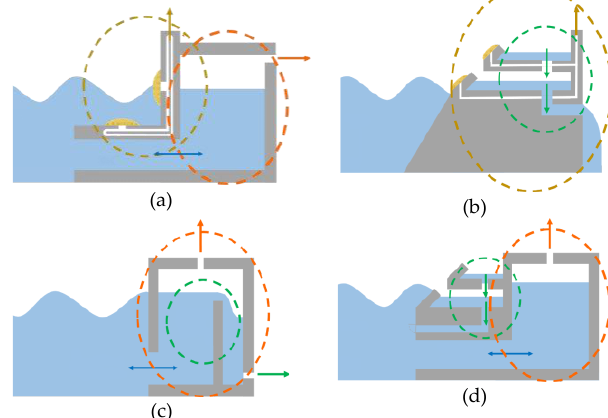
Fig. 3. Combination of (a) flexible membranes and OWC, (b) flexible membranes and OTD, (c) and (d) OWC and OTD.